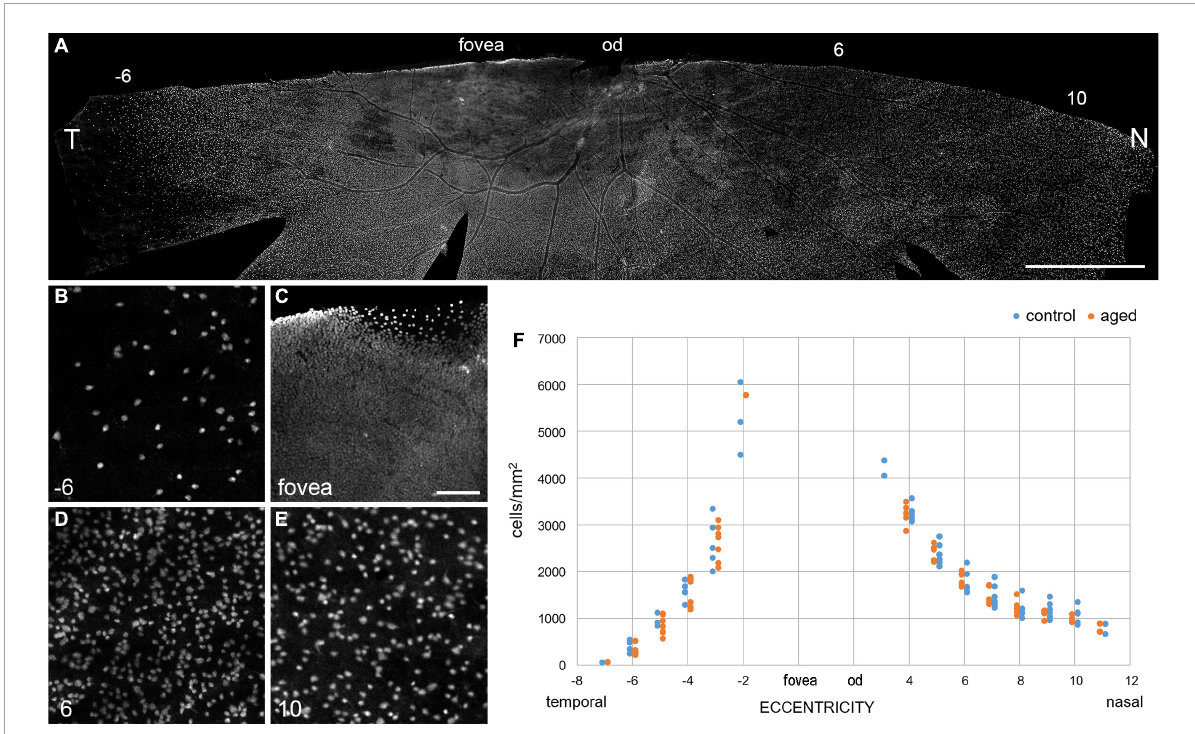
FIGURE5 Ganglion cell density is maintained in old retinas. (A) Inferior retina from a 15-year-old marmoset female immunolabeled with RBPMS. (B–E) High-resolution images from areas along the temporal-nasal axis illustrate large changes in cell density with eccentricity (given in mm at bottom left). (F) Quantification of the decrease in ganglion cell density with eccentricity (distance from the fovea in mm) in aged and control retinas. Note that the ganglion cell density is much lower on the temporal side at 6 mm (–6) than on the nasal side at 6 and 10 mm. T, temporal; N, nasal; od, optic disc. Scale bars, in (A) 2 mm, in (C) 100 µ m for (B–E).